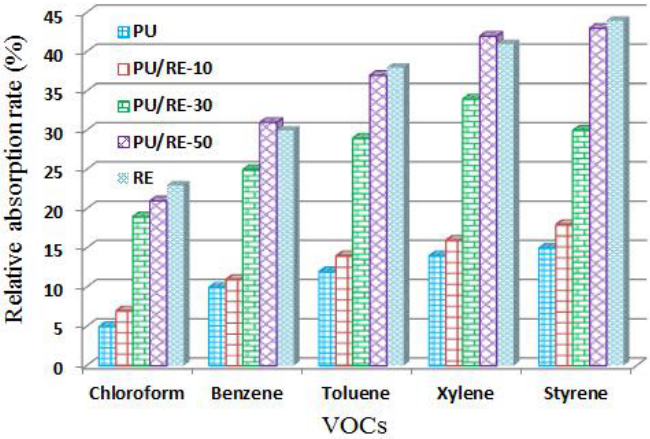
Figure 7. VOC absorption capacity of different nanofibrous mats.